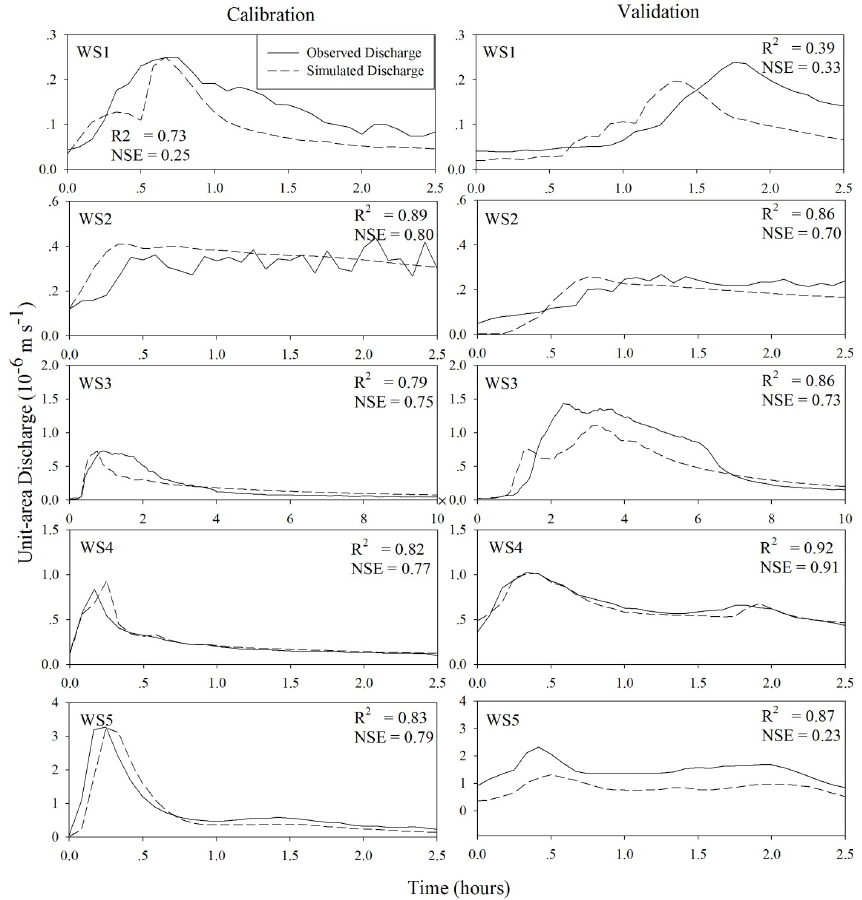
Fig. 3. Hydrograph segments for calibration (left column) and validation (right column) of the five models (WS1 to WS5). Discharge was standardized by watershed area.